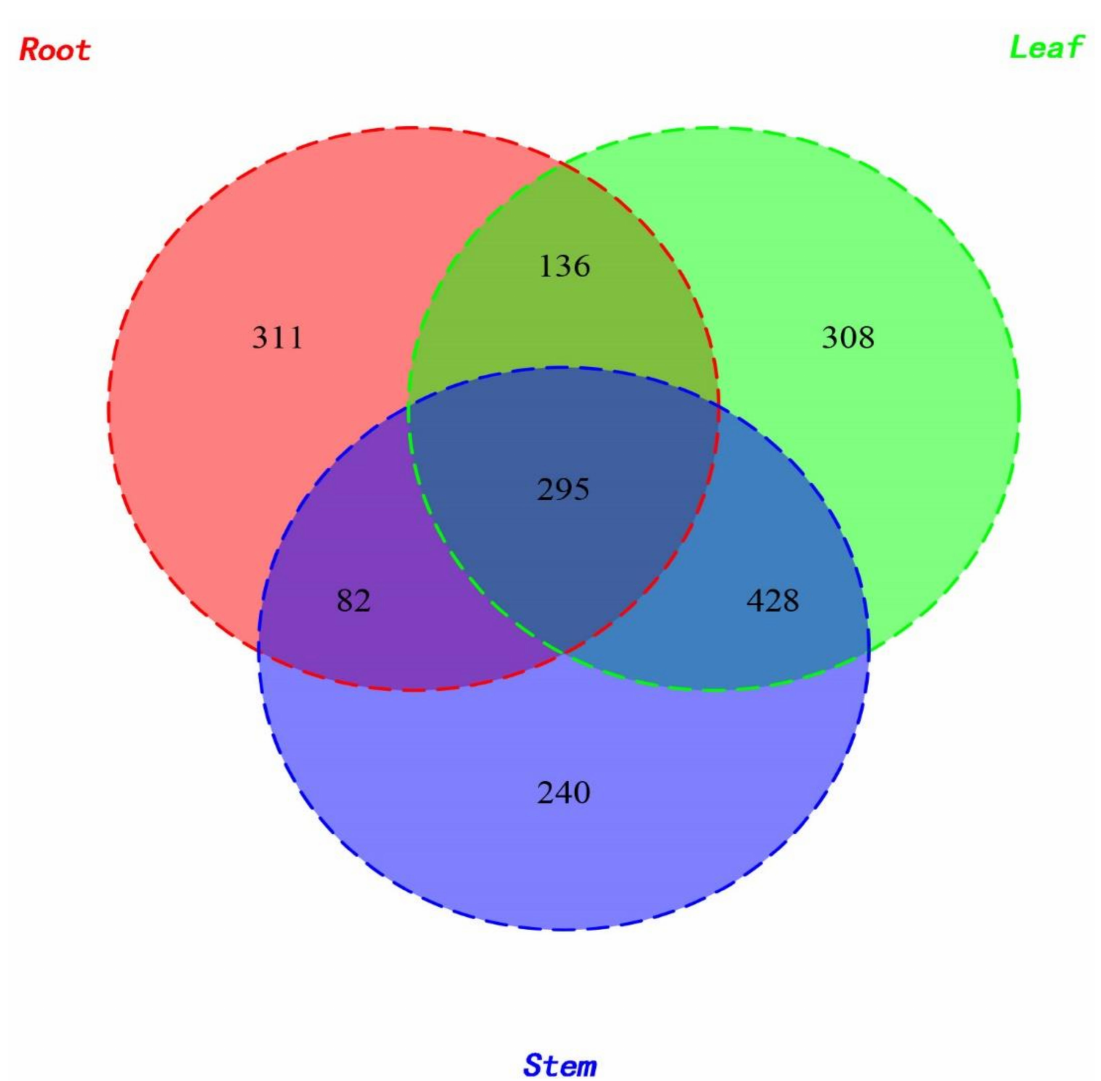
Figure 2. Venn diagram showing the intersections of the identities of the endophytic fungal communities along with the plant